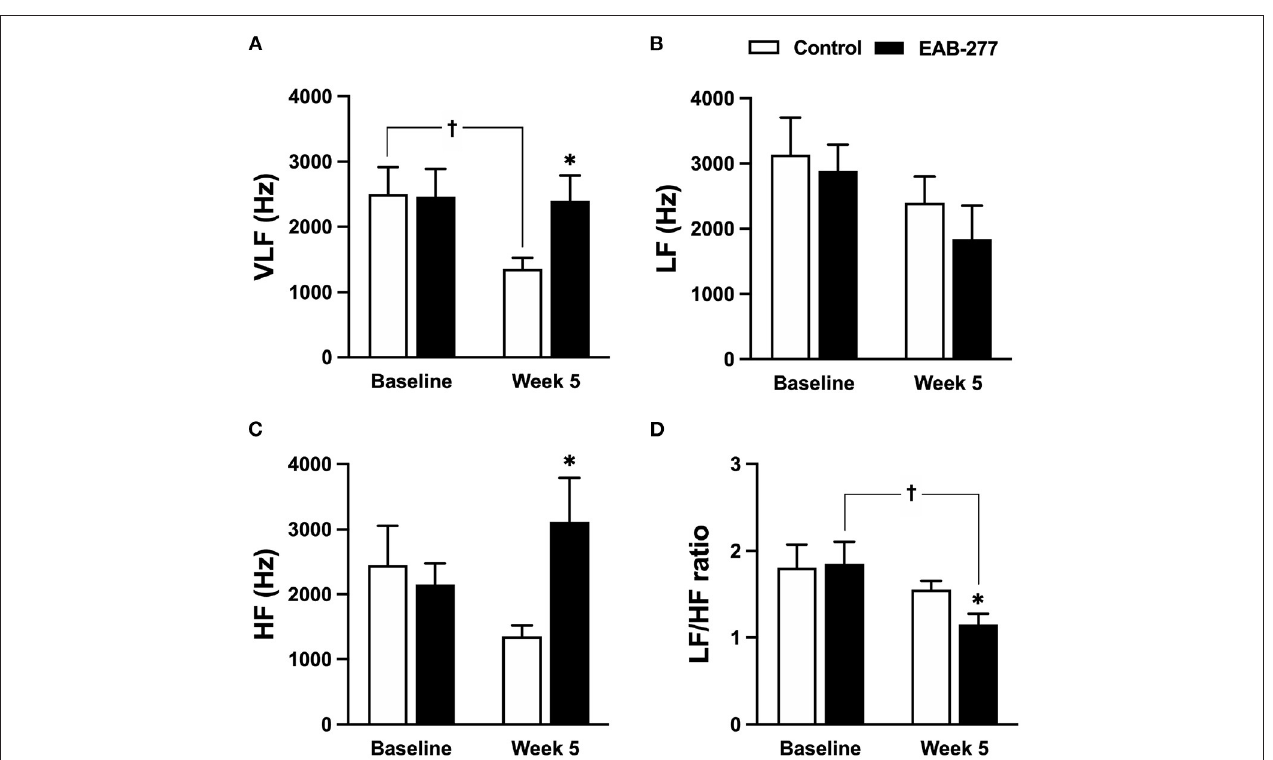
FIGURE 6 | Effect of standard treatment and EAB-277 ® on frequency-domain heart rate variability in tracheal collapse dogs. Frequency-domain HRV demonstrated that (A) VLF, (B) LF, (C) HF, and (D) LF/HF ratios were not different between groups at baseline. At week five, frequency-domain HRV in the control group (A–D) showed that (A) VLF parameter was decreased compared to baseline, whereas (B) LF, (C) HF, and (D) LF/HF ratio at week 5 were not different from baseline. In the EAB-277 ® group, (C) the HF parameter was increased at week 5 compared to the control group, and (D) the LF/HF ratio at week 5 was decreased compared to baseline, whereas (A) VLF, (B) LF, and (C) HF were not different before and after treatment. VLF, Very low-frequency component; LF, Low frequency component; HF, High frequency component. LF/HF ratio, Low frequency/high-frequency component. * P ≤ 0.05 compared to baseline in the same group. † P ≤ 0.05 compared to baseline in the same